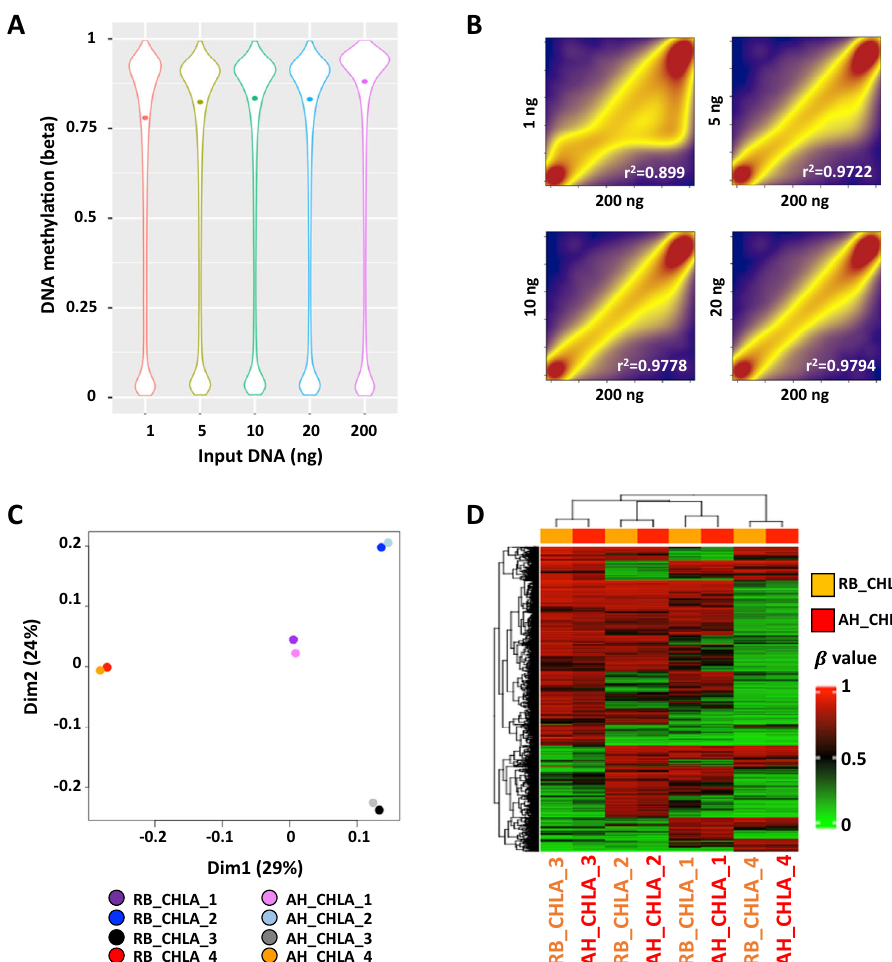
Fig. 2 | DNA methylation pro fi les in AH cfDNAs are highly concordant with paired primary RB tumors. A Violin plot showing the global DNA methylation level of sonicated DNA from the HCT116 cell line. DNA input amounts for EPIC methylation array assays are shown at the bottom. Non-sonicated bulk DNA (200ng)wasusedascontrol.Themedianmethylationvaluesareshownindotsfor eachsample. B SmoothKernelscatterplotsshowingtheDNAmethylationpatterns of different amounts of sonicated DNA input DNA (y-axis) compared to the